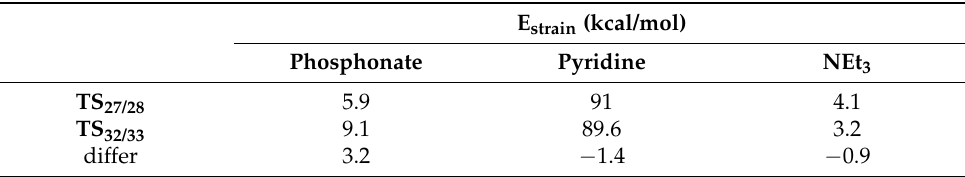
Table 3. Strain energies of pyridine, phosphonate and NEt 3 moieties in the TS 27/28 and TS 32/33 transition states.